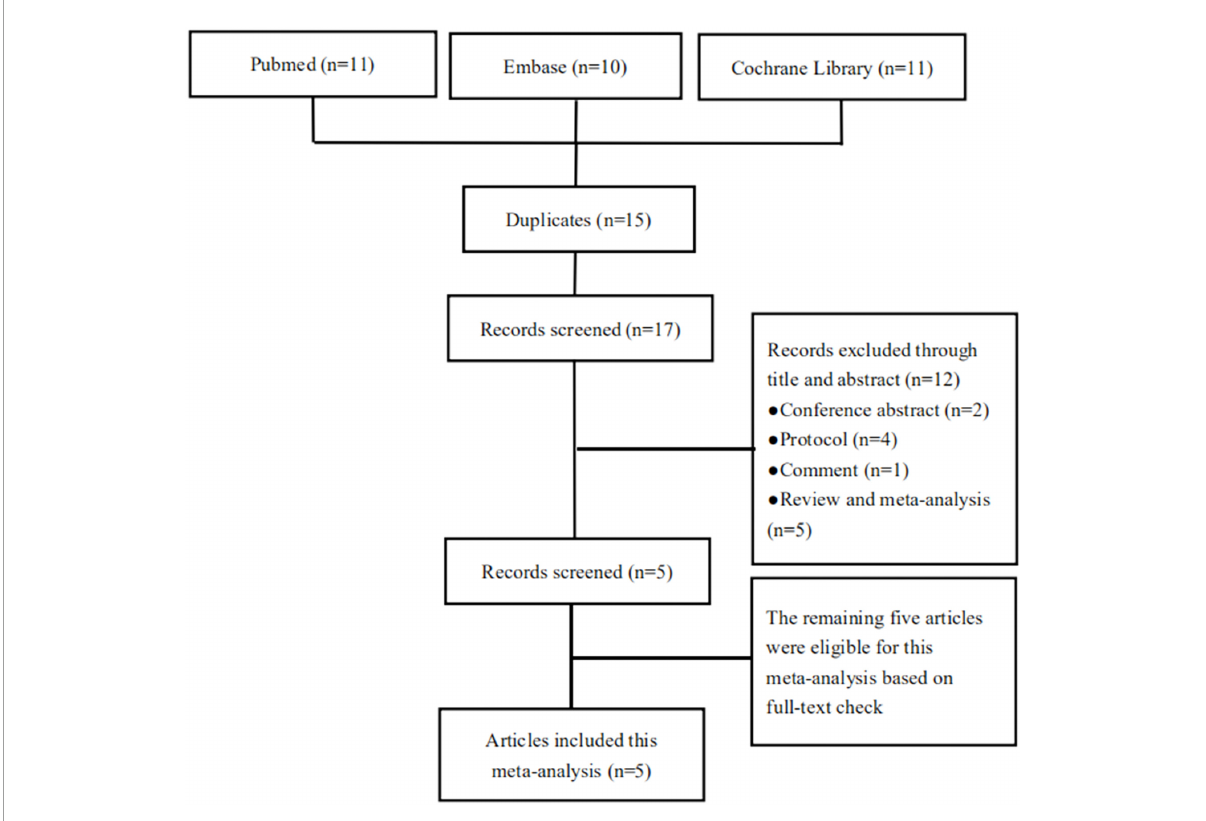
FIGURE1 Screening process of the eligible